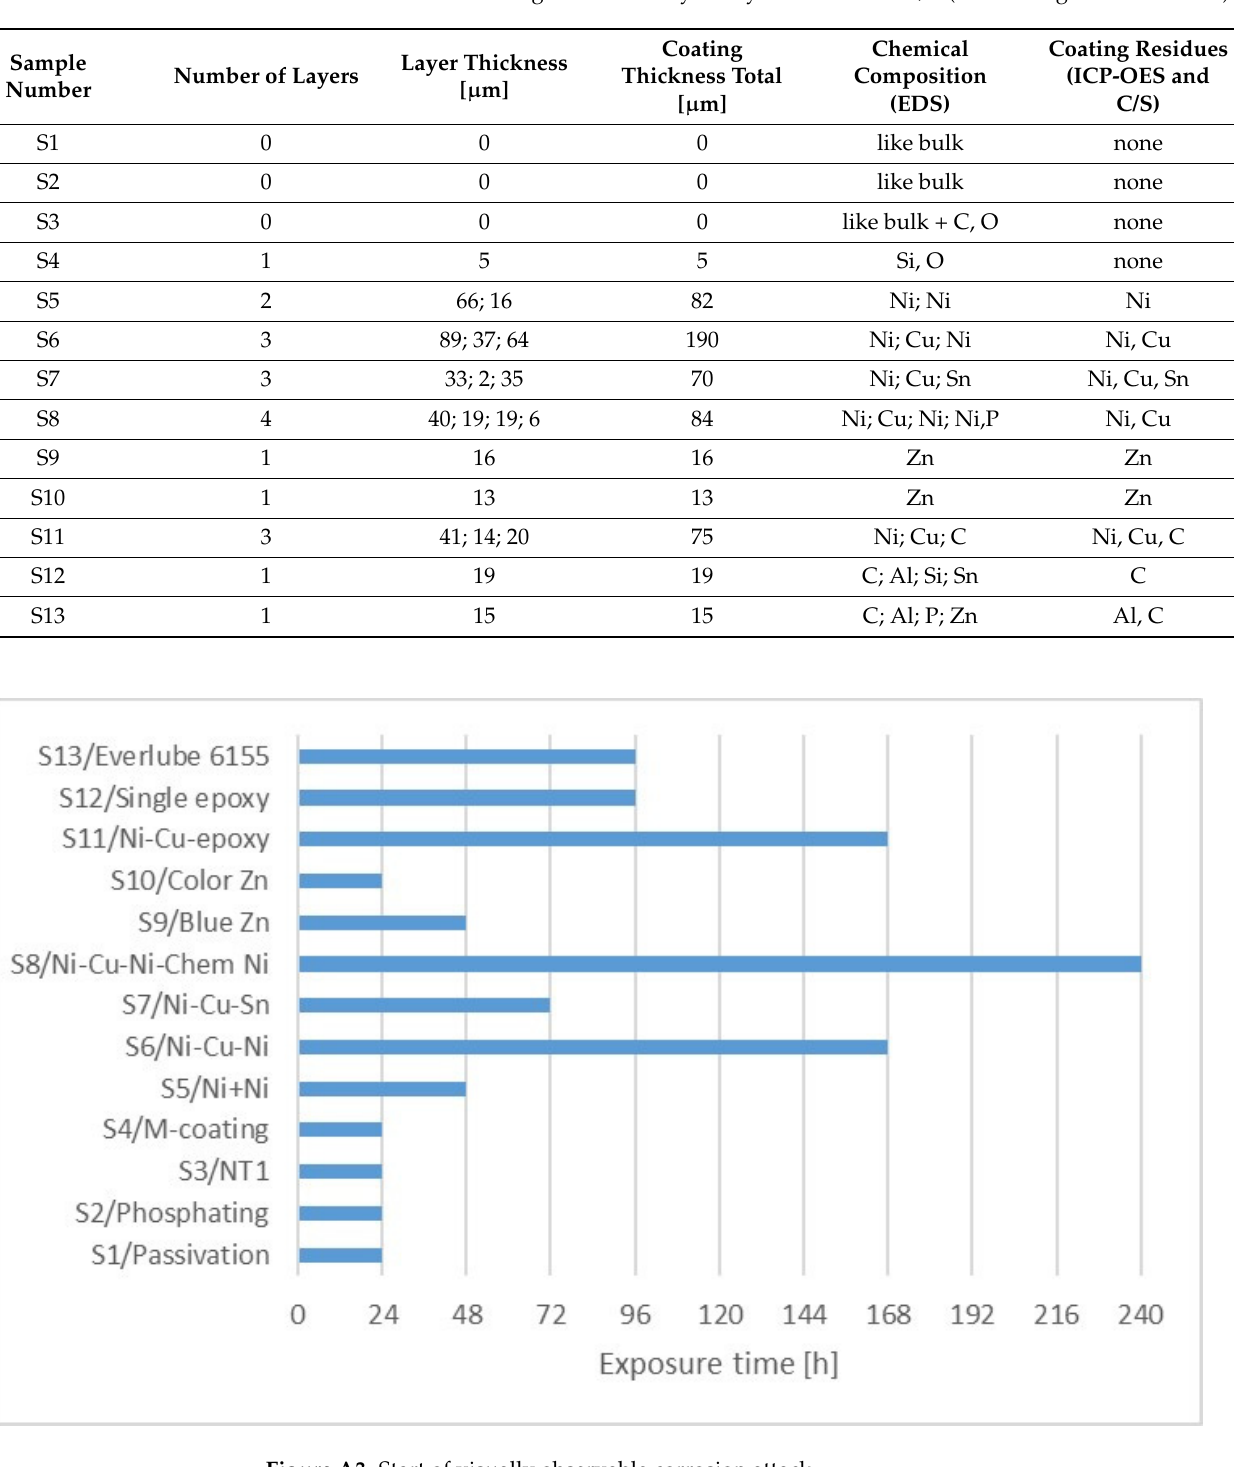
Table A2. Coating thickness and elemental distribution, analysed with SEM (see also Figure A2) and measured elemental coating residues analyzed by ICP-OES and C/S (see also Figures A5 and A6).